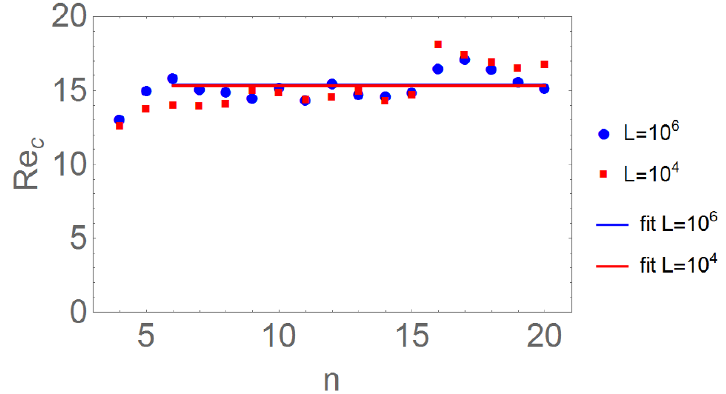
Figure 12 . The critical Reynolds number of a two dimensional (cid:13)ow vs. the initial wave number n . In black the numerical results for M (cid:24) 0 : 01 (cid:28) 1 ( L = 10 6 ) resulting in Re c = 15 : 38 (cid:6) 0 : 81 while ignoring the two points on the left. In blue the numerical results for M (cid:24) 1 ( L = 10 4 ) resulting